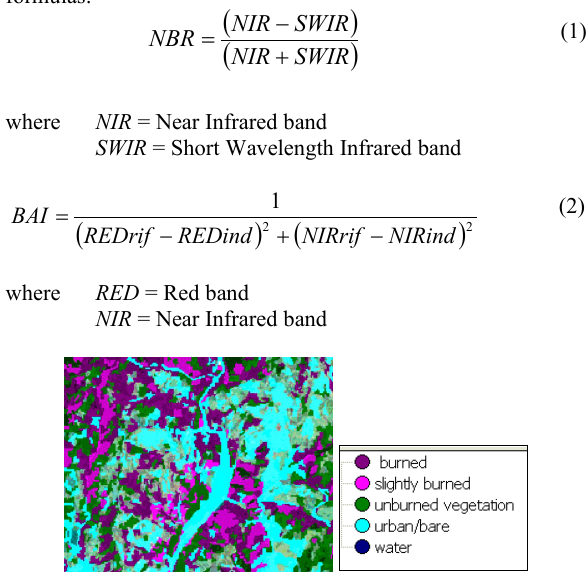
Figure 2, 3. Scenes Landsat and Ikonos available for the province of Reggio Calabria